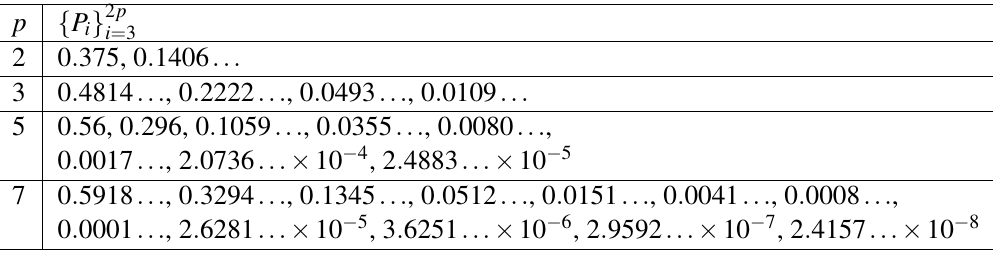
Table 2 Sequence { P i } 2 p